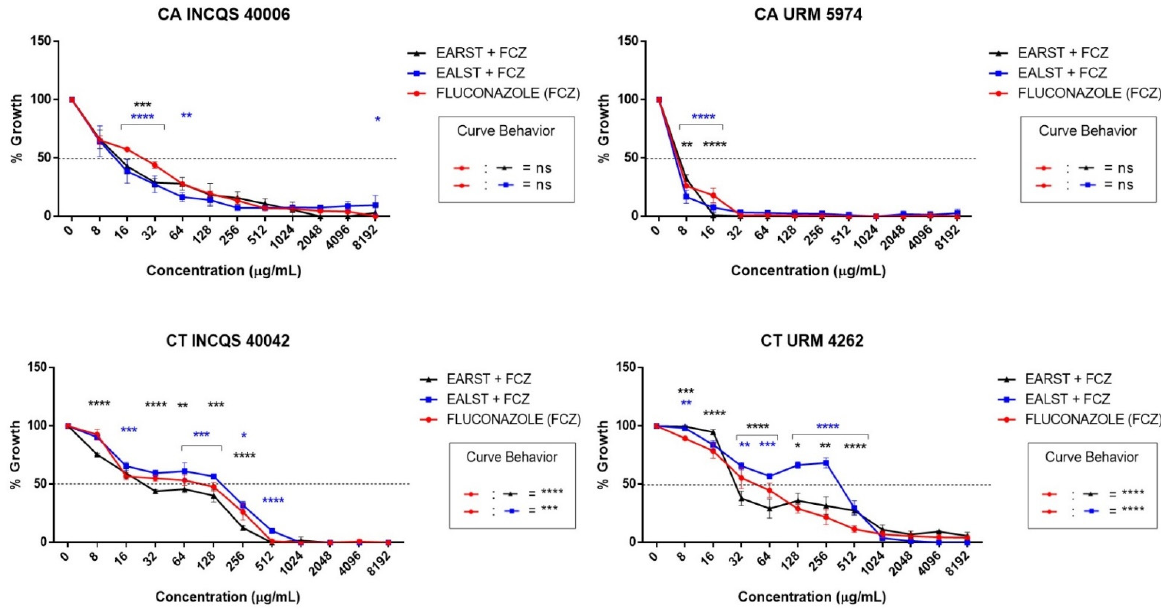
Figure 2. Evaluation of the modifying effect of fluconazole action by extracts. CA: Candida albicans